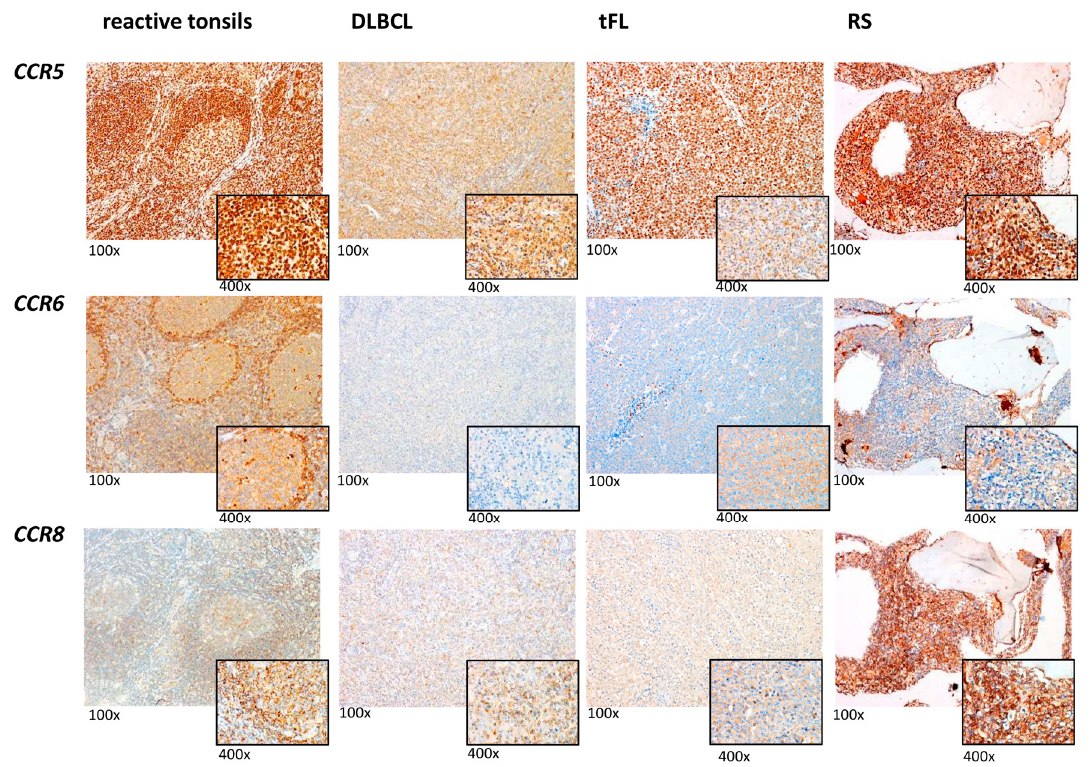
Figure 4. Representative immunohistochemical stains of CCR5, CCR6, and CCR8 expression in reactive tonsils, de novo DLBCL, tFL, and RS. All images were captured using an Olympus BX51 microscope and an Olympus E-330 camera (magnification 100 × for the overview and magnification 400 × for the small picture). Table 2. Mean of the percentage and immunoreactive score (IRS) of positive cells of CCR1,